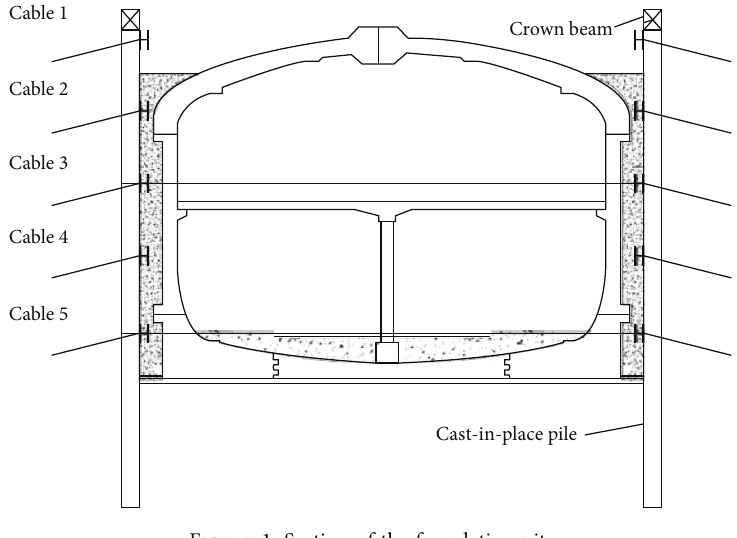
Figure 1: Section of the foundation pit.